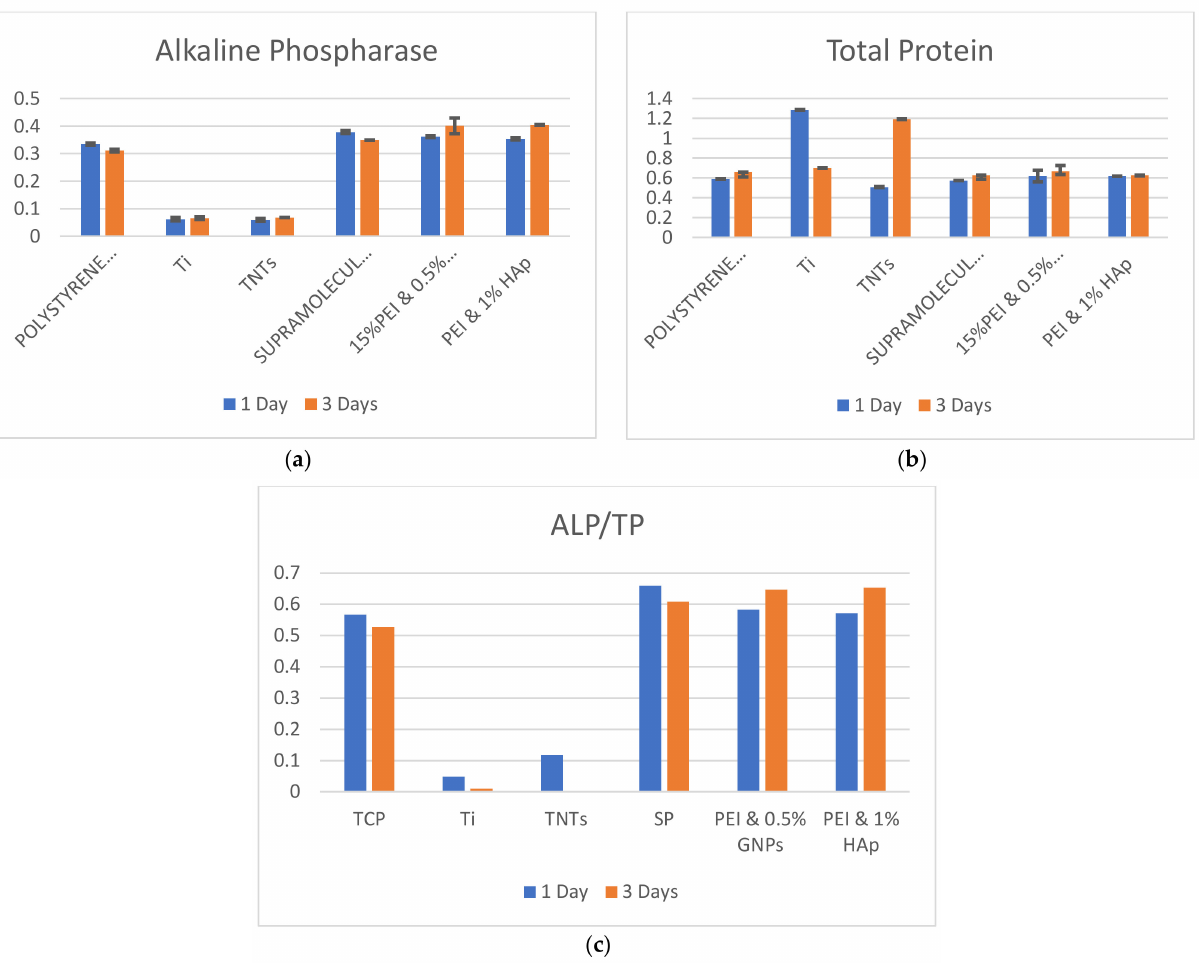
Figure 7. Levels of ( a ) ALP; ( b ) TP and ( c ) ALP/TP-in osteoblasts after 1- and 3-days incubation on polystyrene, titanium and electrospun